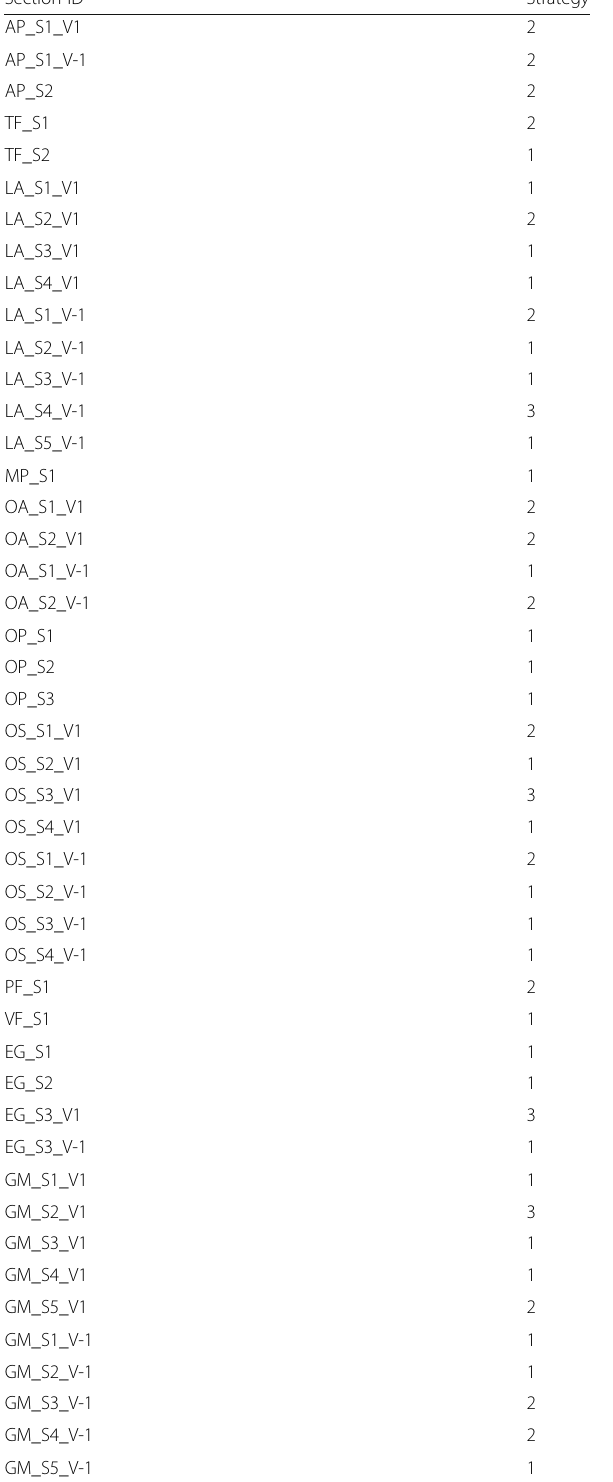
Table 4 Strategies to be implemented on each section for preferred solution S2 Section